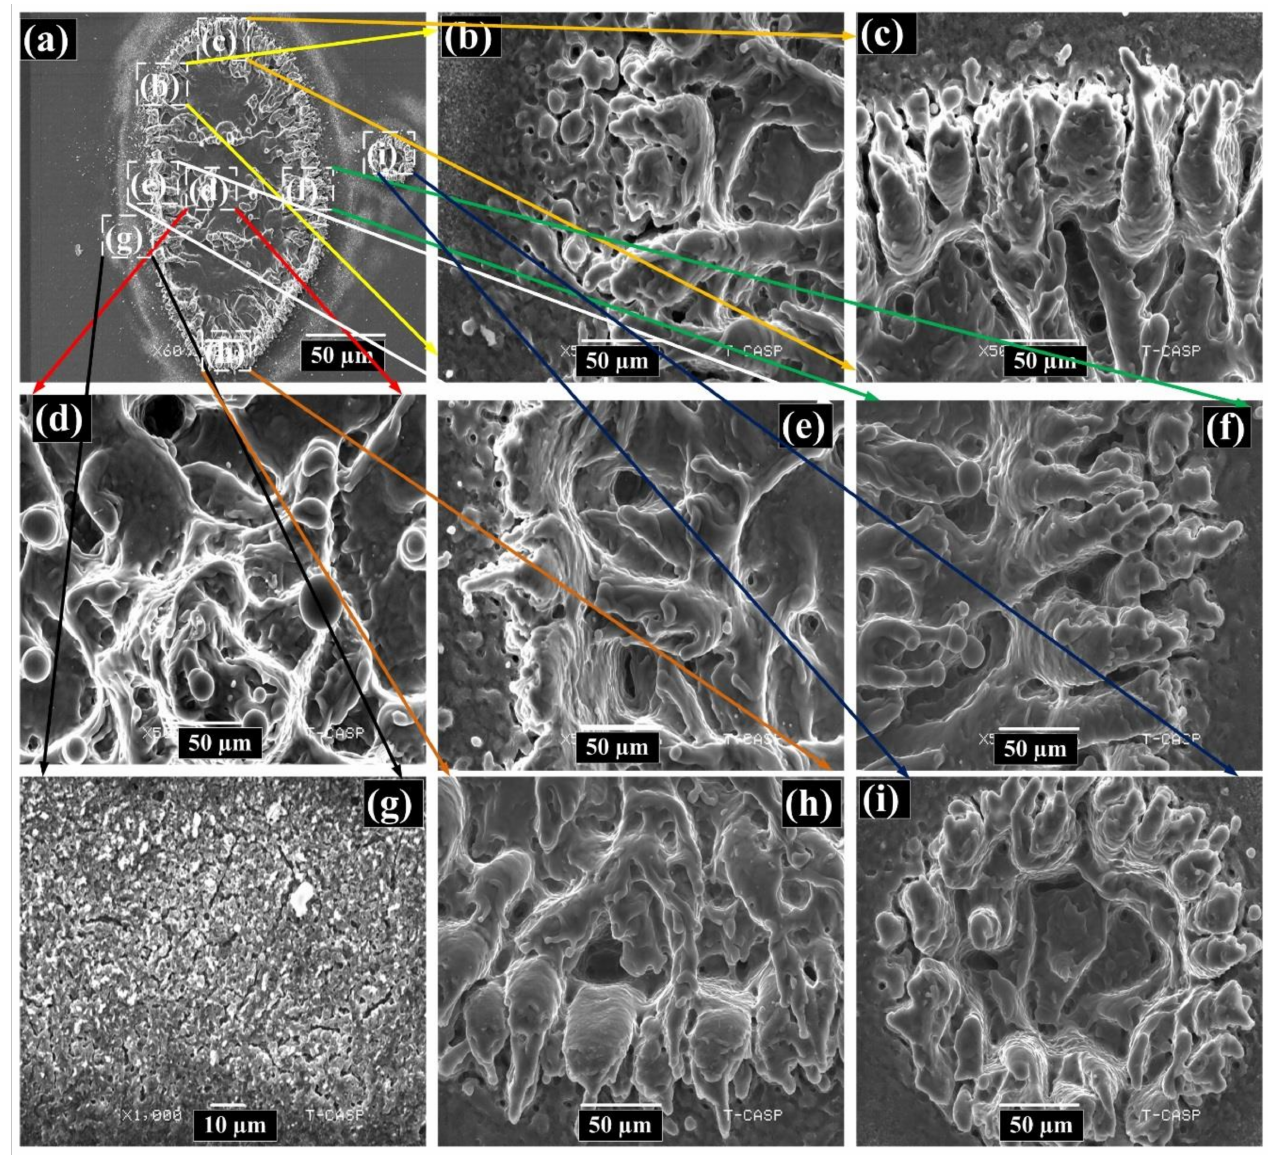
Figure 11. SEM images illustrating the surface morphology of the laser-ablated areas of Mg un- der an ambient environment of Ar at a constant pressure of 5 Torr and a laser irradiance of 2.0 GW/cm 2 in magnetic field where ( a ) laser ablated areas of Mg at the boundaries and cen- tral areas, ( b ) 1st sample of micro-sized cones are formed at the periphery area of the laser-ablated crater, ( c ) 2nd sample of micro-sized cones are formed at the periphery area of the laser-ablated crater, ( d ) Droplets at laser-ablated crater due to maximum deposition of laser energy at the center, ( e ) left-hand side outer boundaries at laser ablated crater ( f ) right-hand side outer boundaries at laser ablated crater ( g ) cavities and particulate formation at laser-ablated crater, ( h ) micro-sized cones, and ( i ) micro-sized